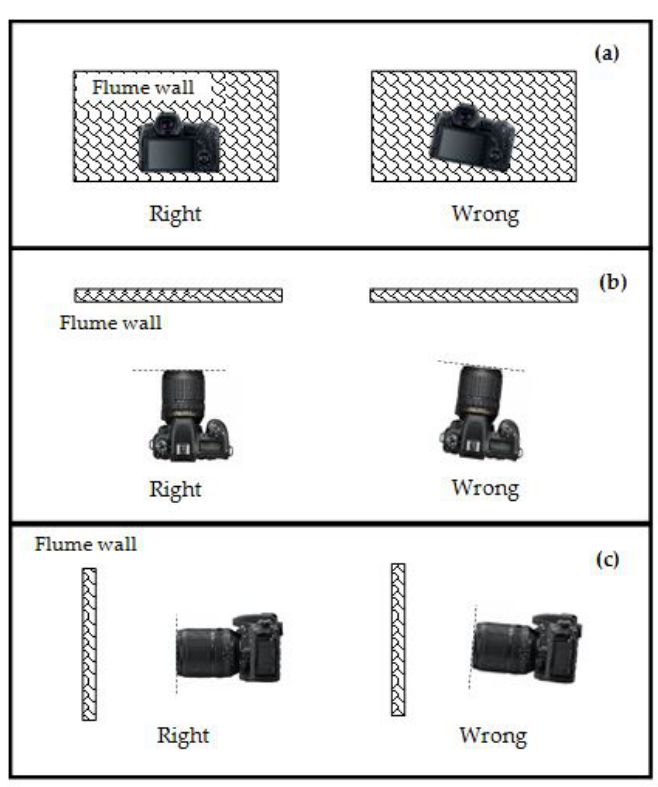
Figure 3. Shooting errors due to camera position ( a ) front view ( b ) top view ( c ) side view.